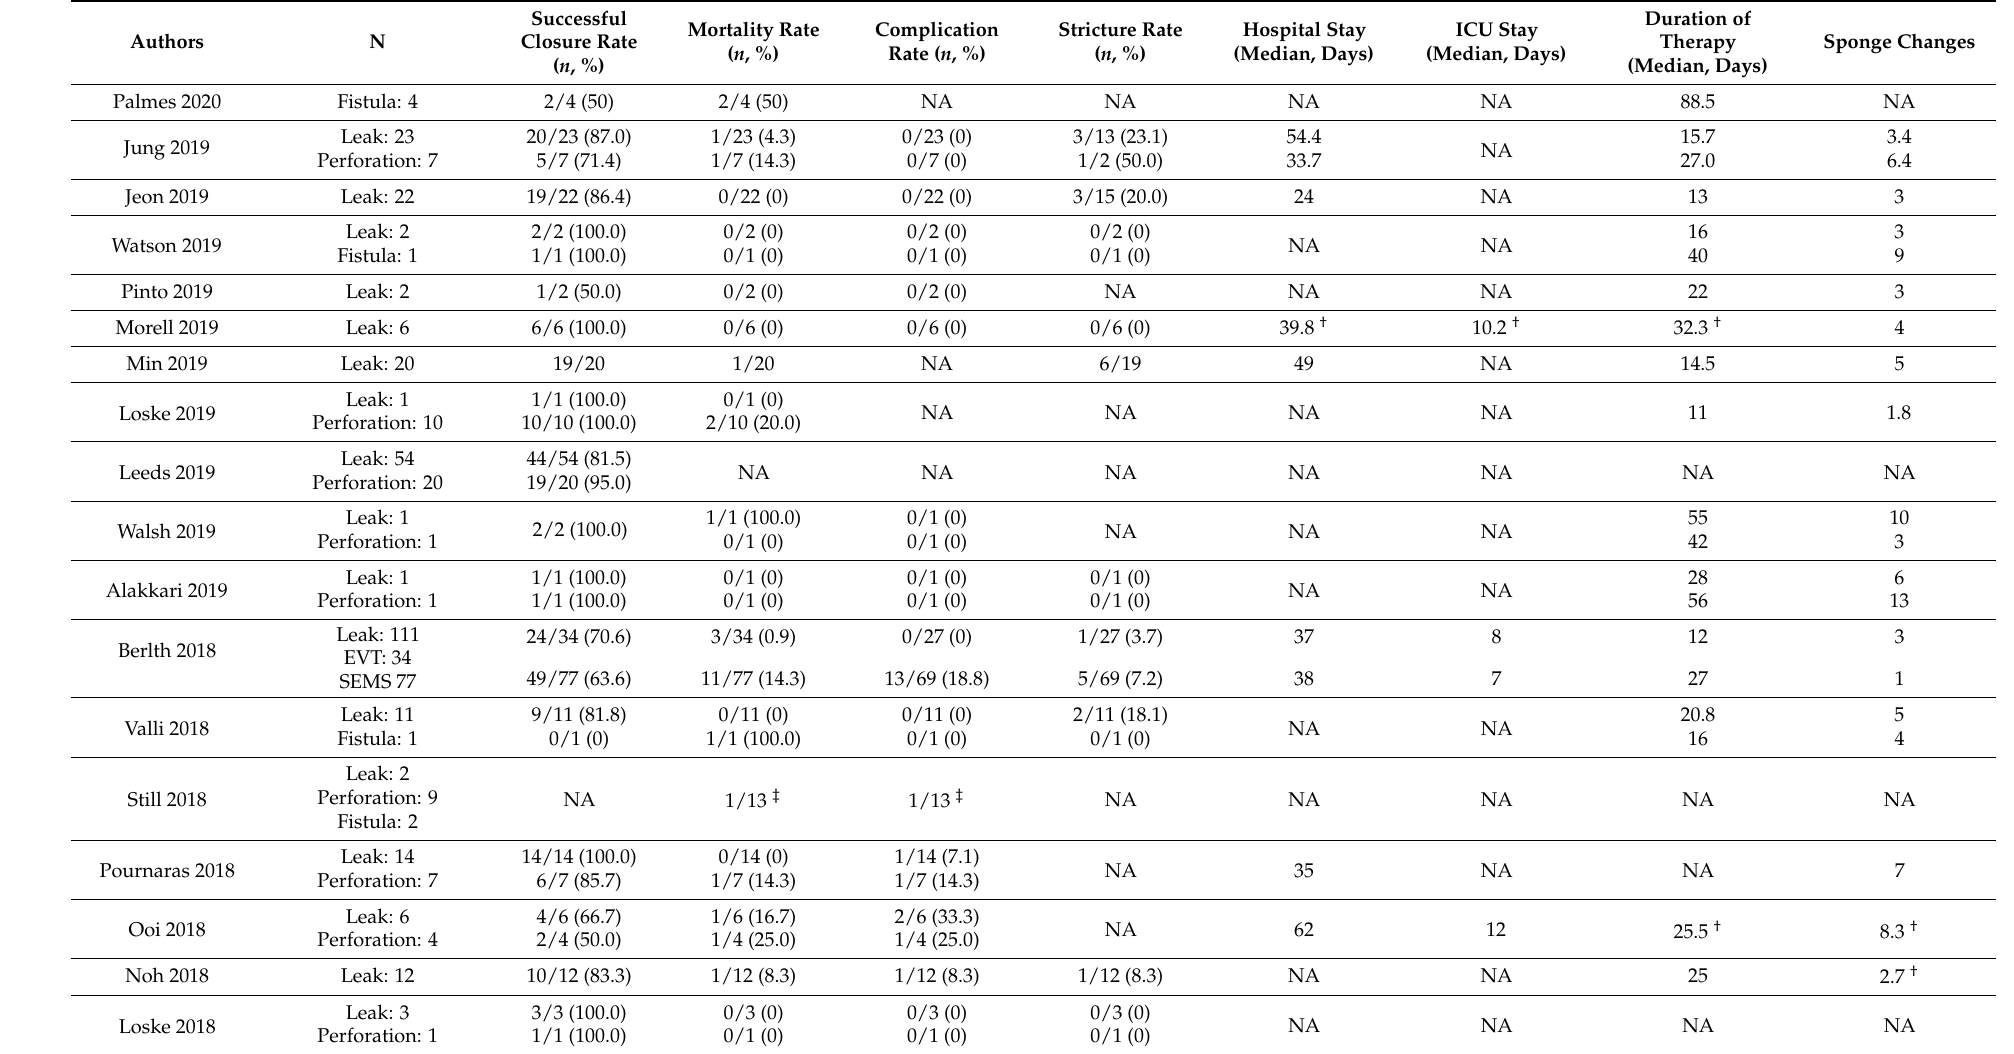
Table 2. Clinical outcomes of 29 studies